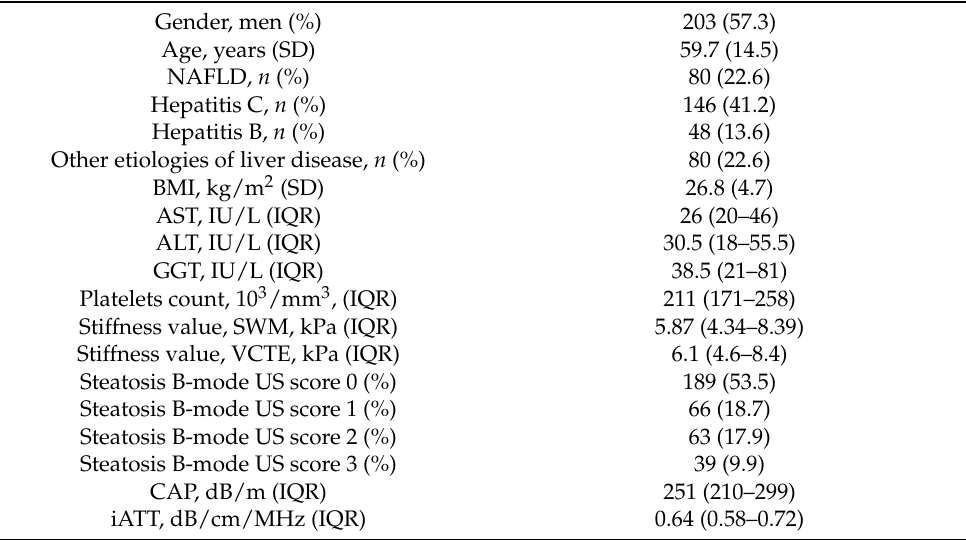
Table 1. Characteristics of the study cohort ( n =